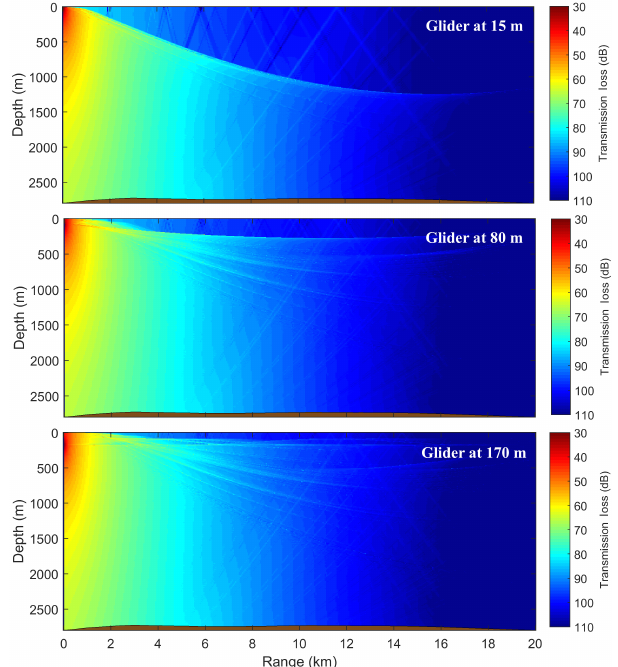
Figure 14. Transmission loss as a function of range and depth for three glider depths (15, 80, and 170m), and for a source frequency of 13.4kHz. The bearing of the plots is due west of the glider po- sition at 40 ◦ 2.6 (cid:48) N, 07 ◦ 23.45 (cid:48) E. As the glider moves deeper, the surface shadow zone narrows and caustics (regions of high inten- sity) appear.